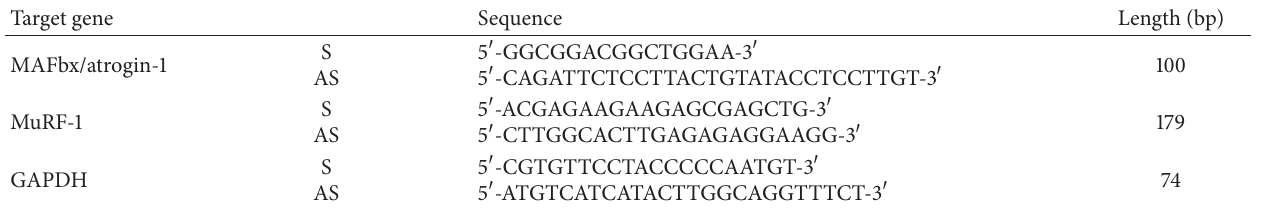
Table 2: Primers used for real-time